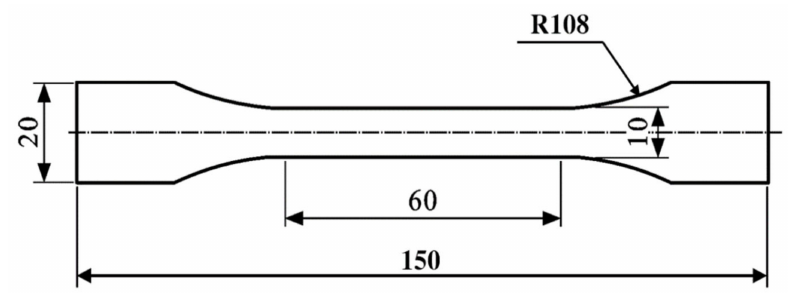
Figure 4. Dumbbell specimen geometry and dimensions in